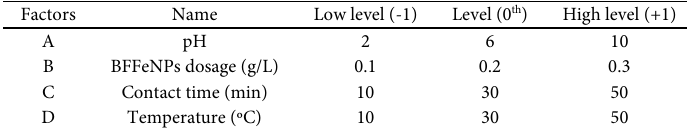
Table 1. Independent factors and its level used in response surface design for Pb (II) removal